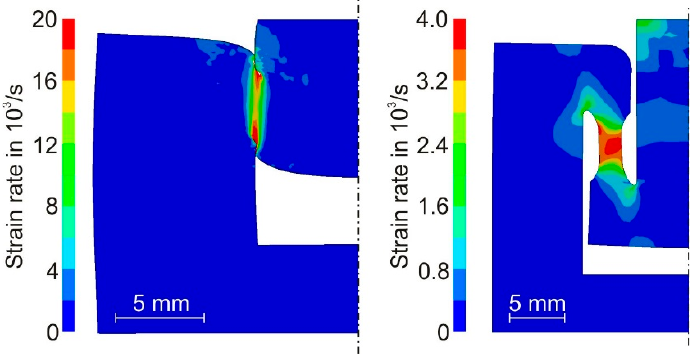
Figure 18. Distribution of the strain rate in DC06 shear and tensile specimens at the moment of maximum strain rate for a hammer velocity of 30 m/s.